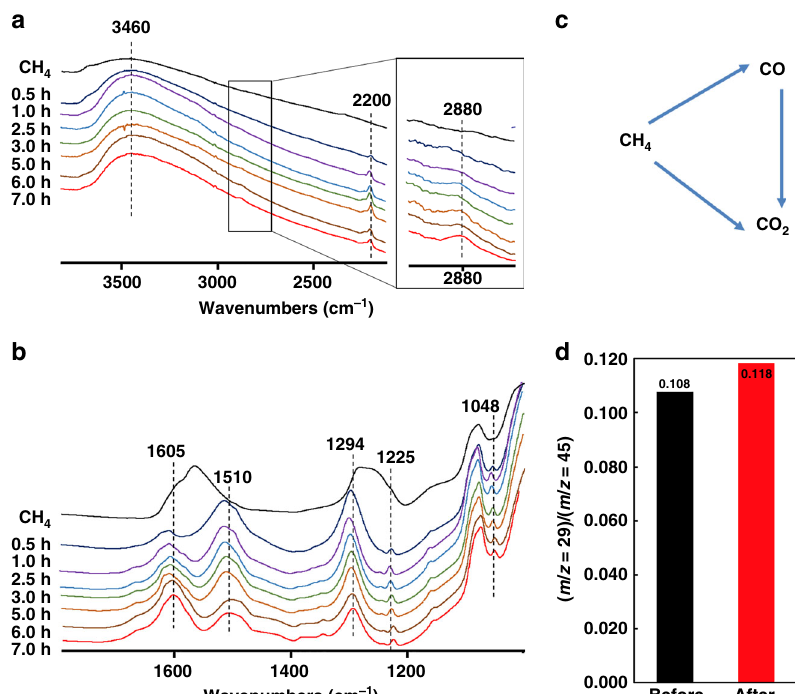
Fig. 4 Intermediates of methane photocatalytic oxidation. a In situ FTIR spectra of the Zn-HPW/TiO 2 catalysts in the region of 3800 – 2100 cm − 1 and b 1800 – 1000 cm − 1 . The spectra were measured under light at different reaction times in CH 4 , c parallel and consequent routes in methane oxidation, d the ( m / z = 29/( m / z = 45) ratio in the isotopic 13 CO 2 labeling experiments: black = before and red = after photocatalytic